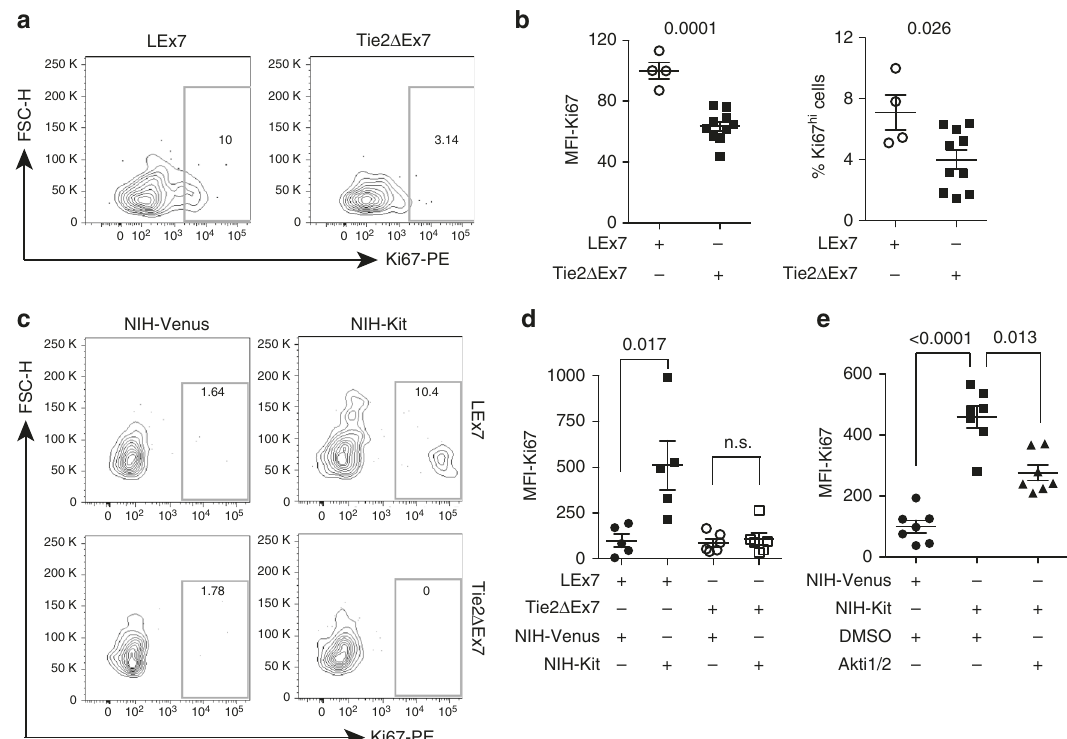
Fig. 6 mKitL induces thymic VEC proliferation in vitro and in vivo. a Ki67 expression in perinatal (P2 – P5) thymic VECs from LEx7 and Tie2 Δ Ex7 mice, as indicated, measured by intracellular fl ow cytometry. Plots are representative of two experiments. b MFI of Ki67 expression (left) and percentage of Ki67 hi cells (right) in perinatal thymic VECs from LEx7 and Tie2 Δ Ex7 mice from a (LEx7: N = 4, Tie2 Δ Ex7: N = 10 in two experiments). Bars show mean ± s.e.m. P -values are shown (Student ’ s t -test). c Ki67 expression in thymic VECs from LEx7 (left) and Tie2 Δ Ex7 mice (right), co-cultured with NIH-Venus or NIH- Kit cells as indicated and measured by intracellular fl ow cytometry. Plots are representative of two experiments. d MFI of Ki67 expression in thymic VECs from LEx7 ( N = 5, two experiments) and Tie2 Δ Ex7 mice ( N = 6, two experiments), co-cultured with NIH-Venus or NIH-Kit cells as indicated and measured by intracellular fl ow cytometry. Bars show mean ± s.e.m. P -values are shown (Student ’ s t -test). e MFI of Ki67 expression in thymic VECs, co-cultured with NIH-Venus ( N = 7, two experiments), or NIH-Kit cells in the presence ( N = 7, two experiments) or absence ( N = 7, two experiments) of Akti1/2 for 6 h, measured by intracellular fl ow cytometry. Bars show mean ± s.e.m. P -values are shown (Student ’ s t